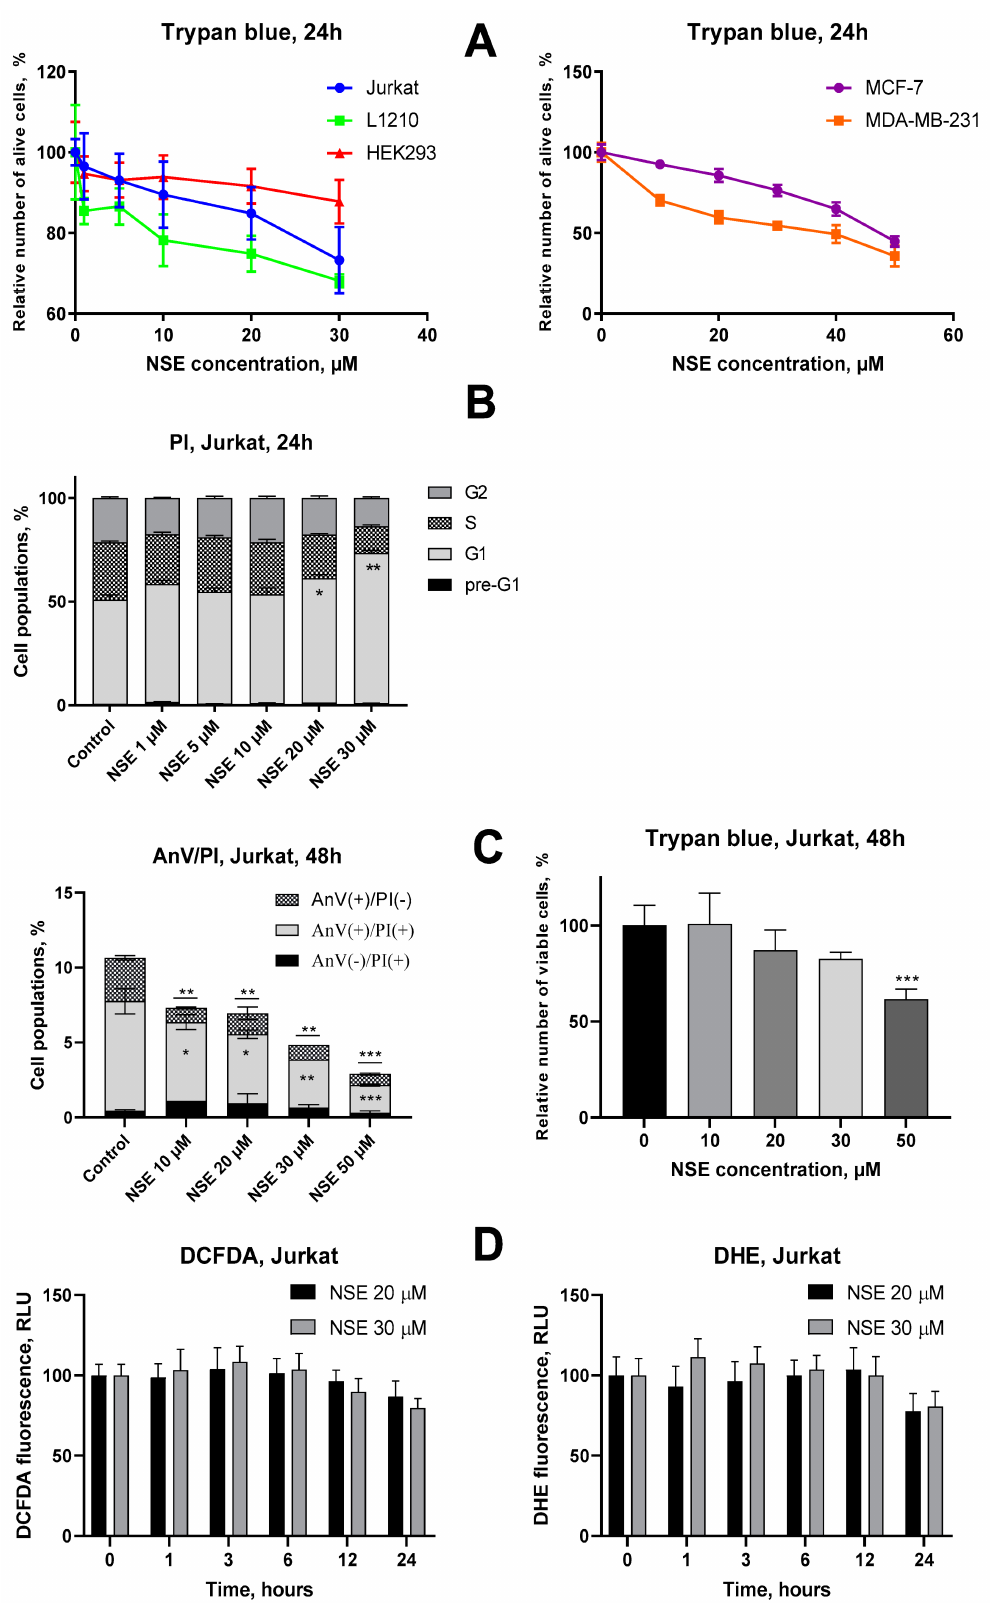
Figure 3. Evaluation of cytostatic and cytotoxic activities of NSE in vitro. ( A ) Viability of the indicated cell lines after treatment with various concentrations of NSE for 24 h, analyzed by trypan blue